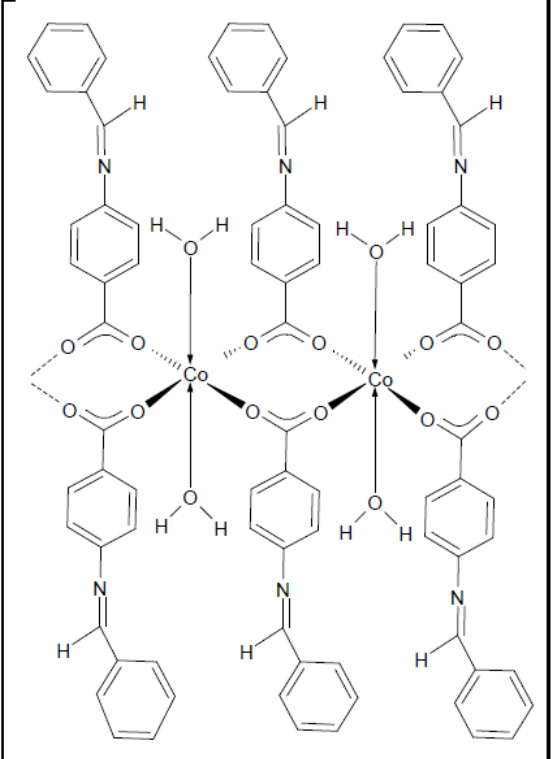
FIGURE 6 – Structural representation of catena -poly-{[trans(diaqua- kO )cobalt(II)]-bis( m - p -(benzylideneamino)benzoato- k²O,O’)